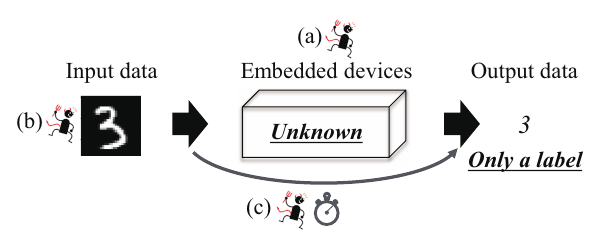
Figure 1: Attack scenario of timing black-box attacks against DNNs on embedded devices with naive